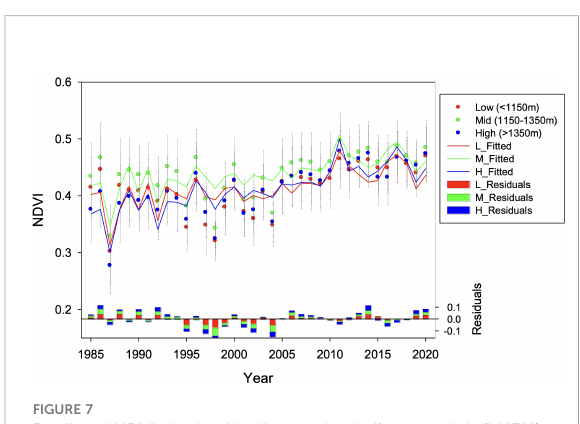
FIGURE 7 Predicted NDVI obtained by linear mixed effects models (LMEM) using climate and physiography as predictors. NDVI was fi tted for low (880-1150 m a.s.l.; L_Fitted in red), mid (1150-1350 m a.s.l.; M_Fitted in green), and high (1350-1550 m a.s.l.; H_Fitted in blue) altitudinal bands. The residuals of the models (bottom bars) were computed as the difference between observed and predicted NDVI; positive bars denote years where observed NDVI values were higher than expected based on climate, while negative bars denote years where observed NDVI values were lower than expected based on